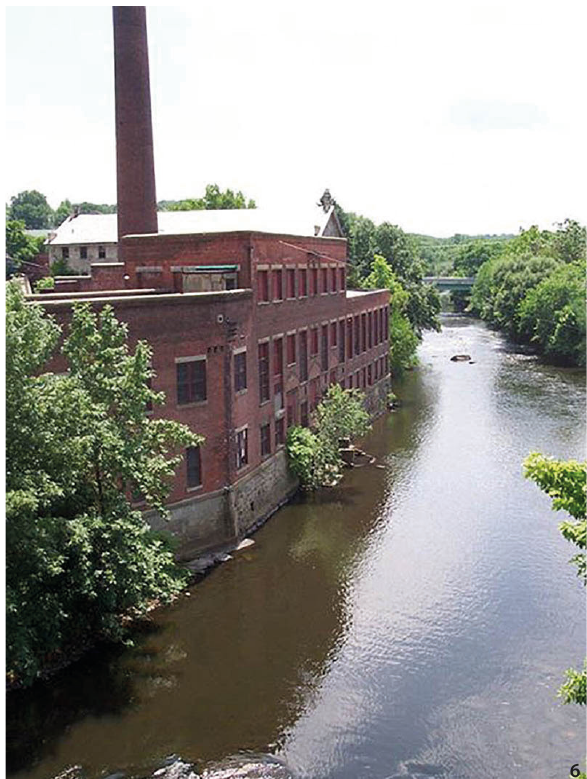
Figure 6 Former textile mill along the Blackstone River in the Black- stone River Valley National Heritage Corridor (Source: U.S. National Park